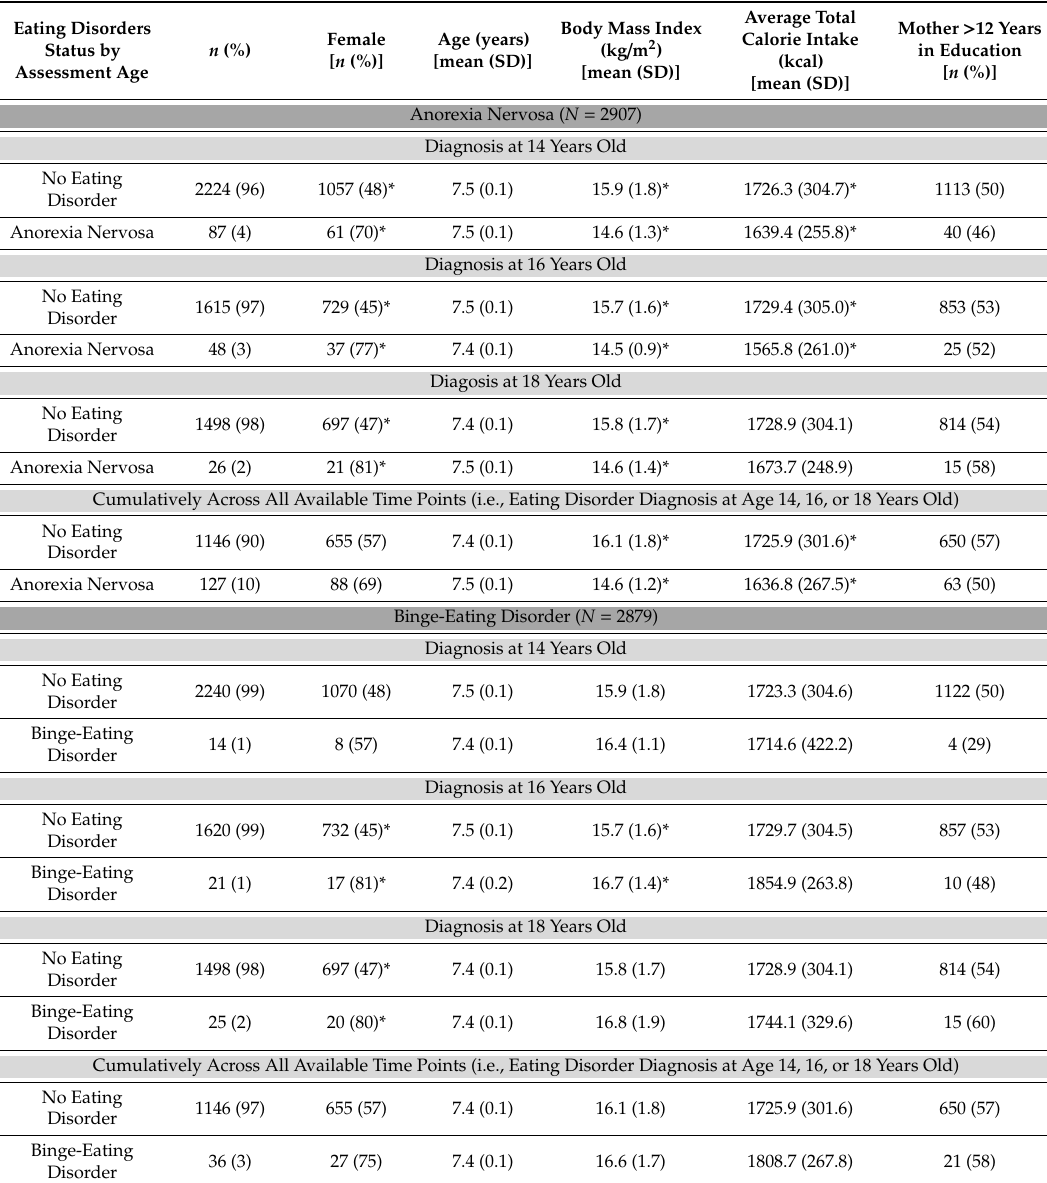
Table 1. Participant characteristics ( n = 2929) at 7 years old stratified by eating disorders diagnosis at age 14, 16, 18 years old and cumulatively across all available time points (i.e., eating disorder diagnosis at age 14, 16, or 18 years old) in the Avon Longitudinal Study of Parents and Children (ALSPAC). Eating disorders diagnoses were derived using questionnaire data and DSM-5 criteria. Note: * indicates p -value <